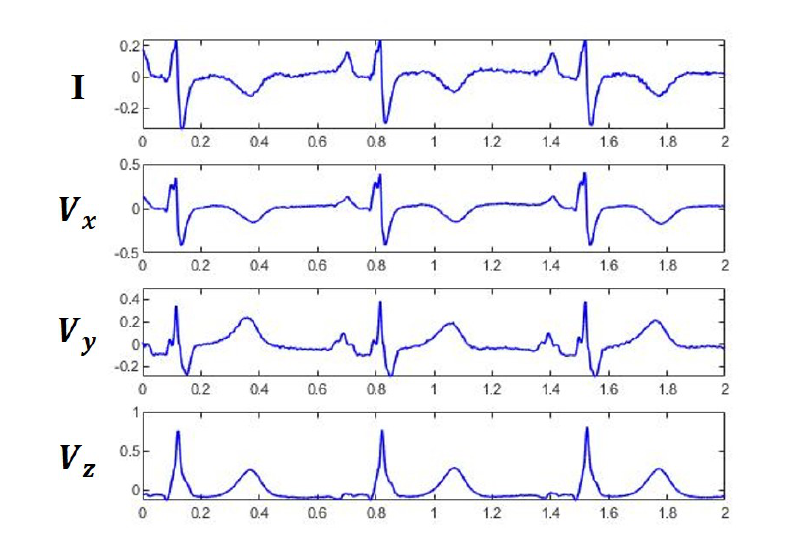
Figure 3. ECG waveforms of measured lead I and Frank XYZ